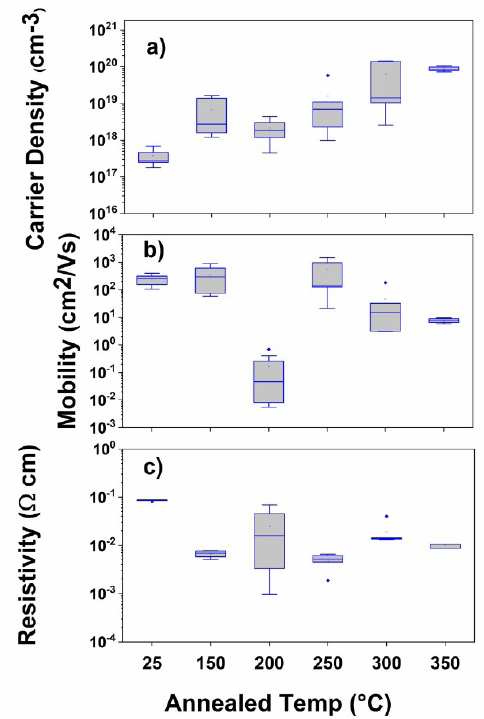
Figure 8. Hall effect results for the nitrogen annealed layers of Bi S at different temperatures a) carrier density, b) mobility and 2 3 c)